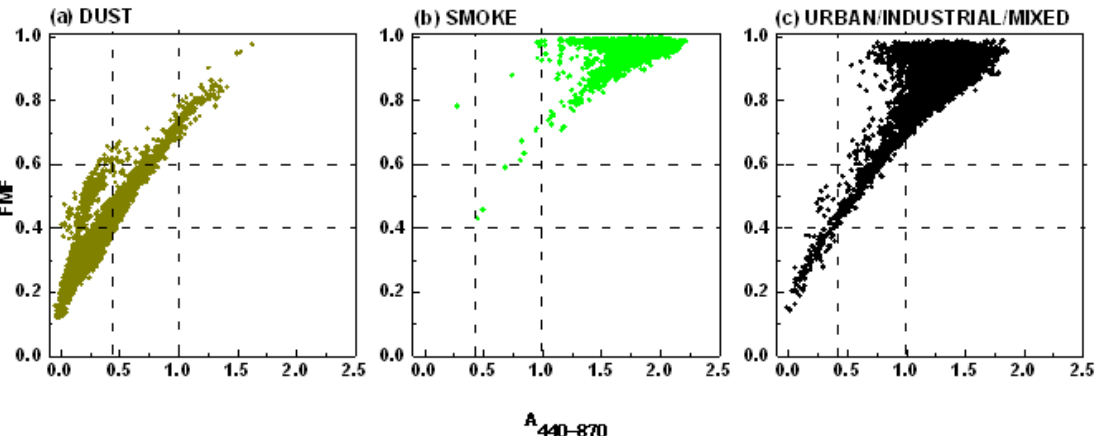
Figure 2. Scatter plot of fine-mode fraction (FMF) versus Ångstöm exponent for the pair of wavelength 440 and 870 nm (Å 440-870 ) for ( a ) dust sites, ( b ) smoke sites and ( c ) urban/industrial/mixed sites. Thresholds of Å 440-870 <0.4 and FMF <0.4 are used to determine the dust particles, Å 440-870 >1.0 is used to distinguish the smoke particles, 0.4 <FMF <0.6 is used to distinguish the mixed particles and FMF > 0.6 is used to distinguish the pollution particles at the respective sites of each aerosol type.